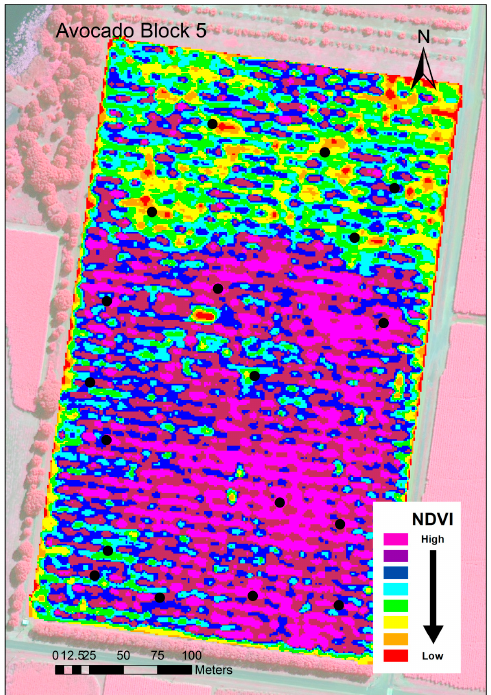
Figure 2. Classified Normalised Difference Vegetation Index (NDVI) images of the five avocado blocks with sampling locations for the 2016 and 2017 season presented as black circles. In Block 1 and 2, the individual tree sampling locations for 2014 are indicated as white circles. (Note some sample locations overlap between years.) Block 1: 14.4 ha, Block 2: 28.2 ha, Block 3: 6.8 ha, Block 4: 14.7 ha, Block 5: 12.7 ha and Block 6: 11.3 ha.